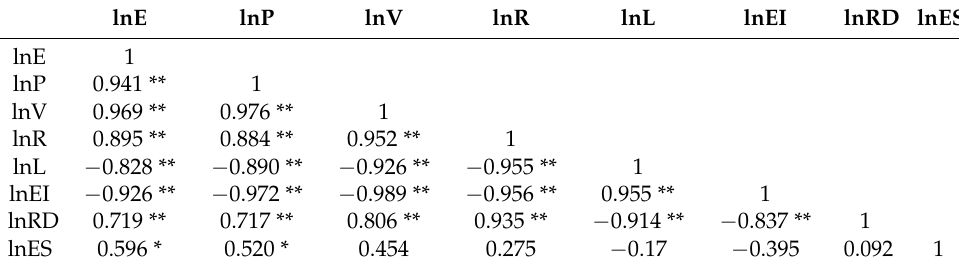
Table 2. Correlation analysis between industrial carbon emission and influencing factors.